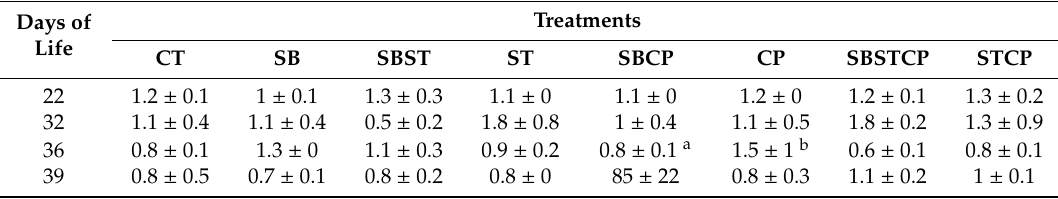
Table 4. Spleen morphometric index of broilers treated with the synbiotic mix and inoculated with Salmonella typhimurium and Clostridium perfringens